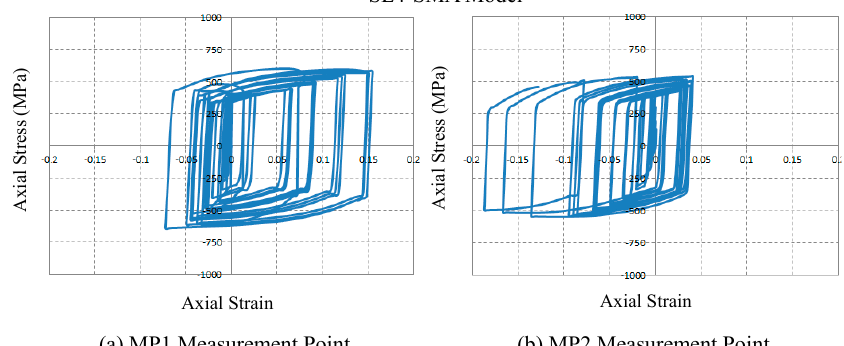
Figure 15. Axial strain components (LE11) distributed over the slip plate damper (SL4-SMA model) according to individual loading steps (Unit: rad).